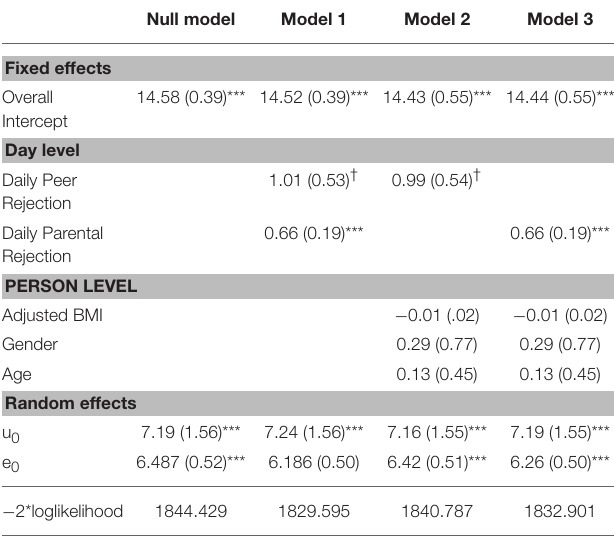
TABLE 2 | Daily emotional eating as a function of daily peer rejection and daily parental rejection and person level